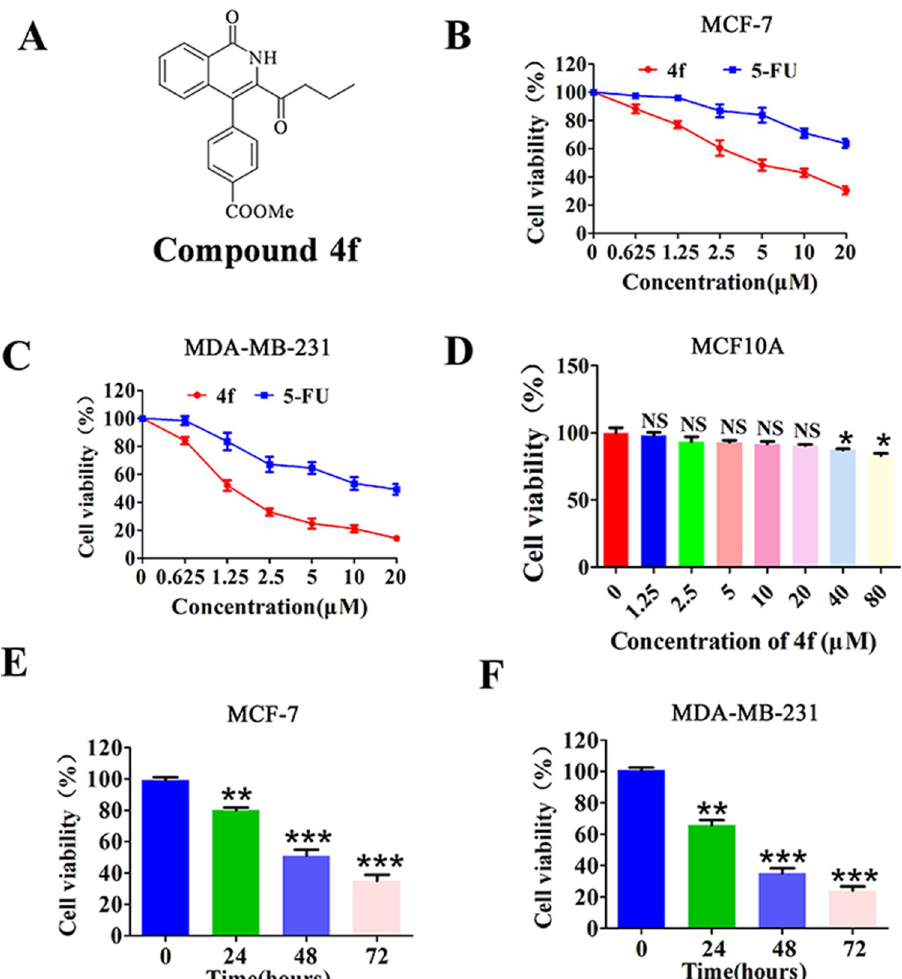
Fig 1. Compound 4f inhibits breast cancer cell viability. (A) The structure of compound 4f . (B-D) The effect of compound 4f on the viability of the breast cancer cells MCF-7 and MDA-MB-231 and human normal mammary epithelial cell MCF10A by CCK8 assay at the indicated concentration, n = 3. (E, F) Time-dependent of 4f on the viability of the MCF-7 and MDA-MB-231 cells assessed by CCK8 assay. NS, not significant different from 0 group, � significantly different from 0 group. � p < 0.05, �� p < 0.01 and ��� p < 0.001, n =